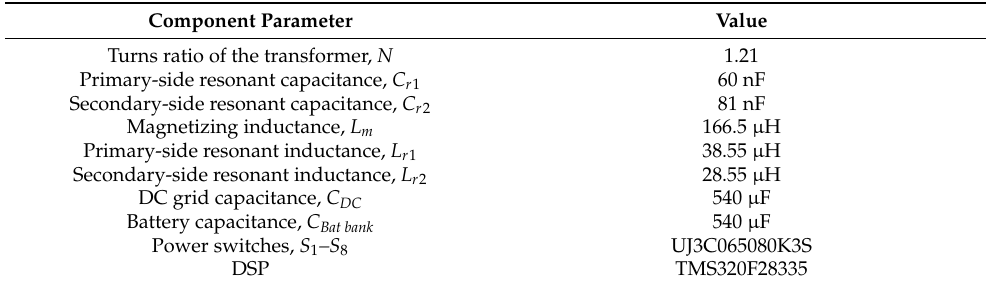
Table 2. Parameter configuration and components used in the fabricated